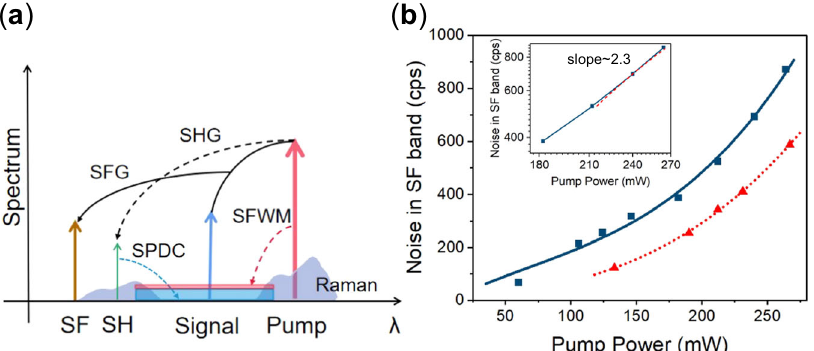
Fig. 3 Noise analysis of the QFC process. a The main noise processes induced by a strong pump fi eld in a QFC chip. b The total on-chip NCR (blue line, square) and the SHG-SPDC induced on-chip NCR (red dotted line, triangle) in the SF band over a detection bandwidth of 0.09 nm in linear coordinate. The inset shows the total on-chip NCR at high pump power in the logarithmic coordinates with the same detection bandwidth and the slope at 240 mW (red short dash).